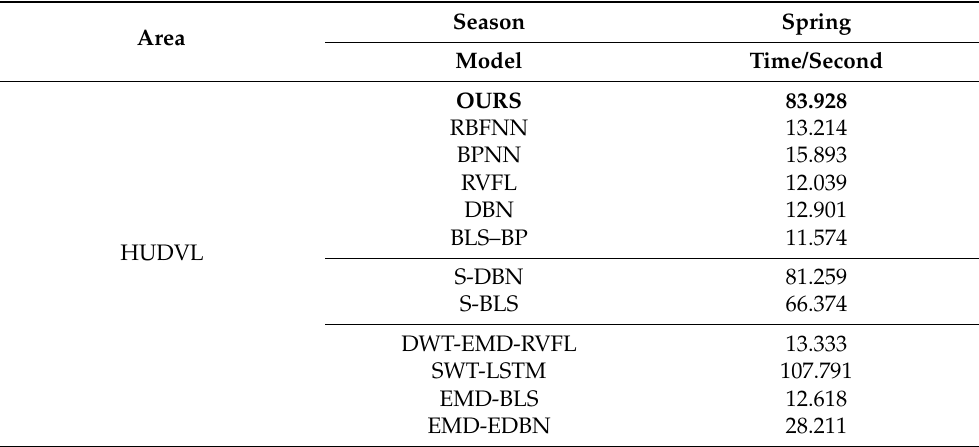
Table 5. The computation times required for each case.